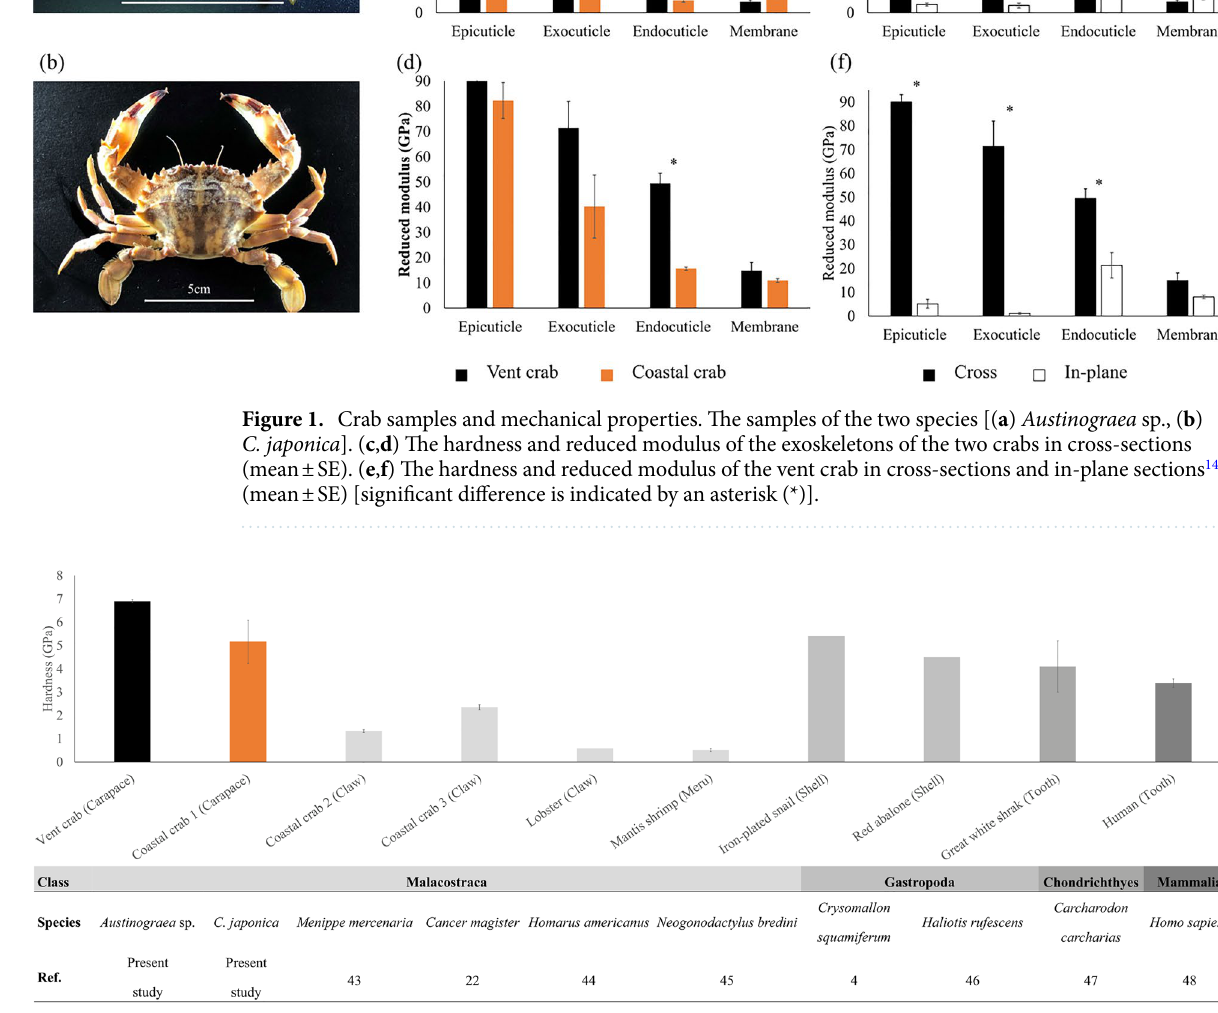
Figure 2. Comparison of the hardness for various species (mean ± SE) 43–48